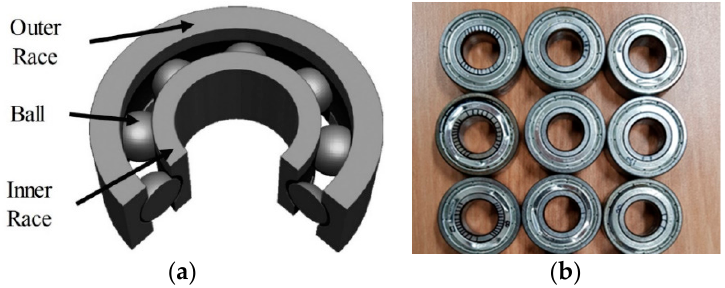
Figure 5. ( a ) Structure of the bearing used in benchmark PMSM; ( b ) Damaged bearing samples.